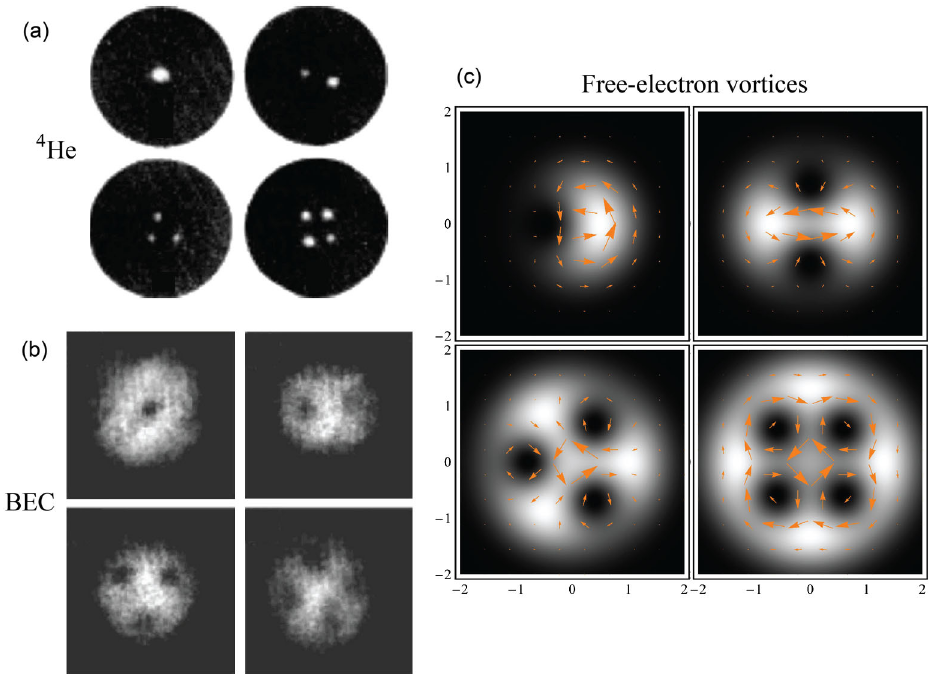
FIG. 10. Comparison of the stable vortex configurations in (a) rotating 4 He (taken from [54]) and (b) rotating trapped BEC (taken from [55]), with (c) nonrotating off-axis vortex superpositions of the lowest-energy Landau modes (same as in Fig. 8 but with ‘ ¼ (cid:1) 1 , (cid:1) 2 , (cid:1) 3 , (cid:1) 4